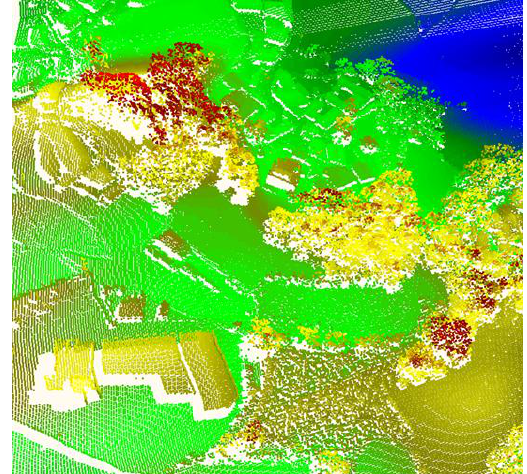
Figure 13. Georeferenced LiDAR